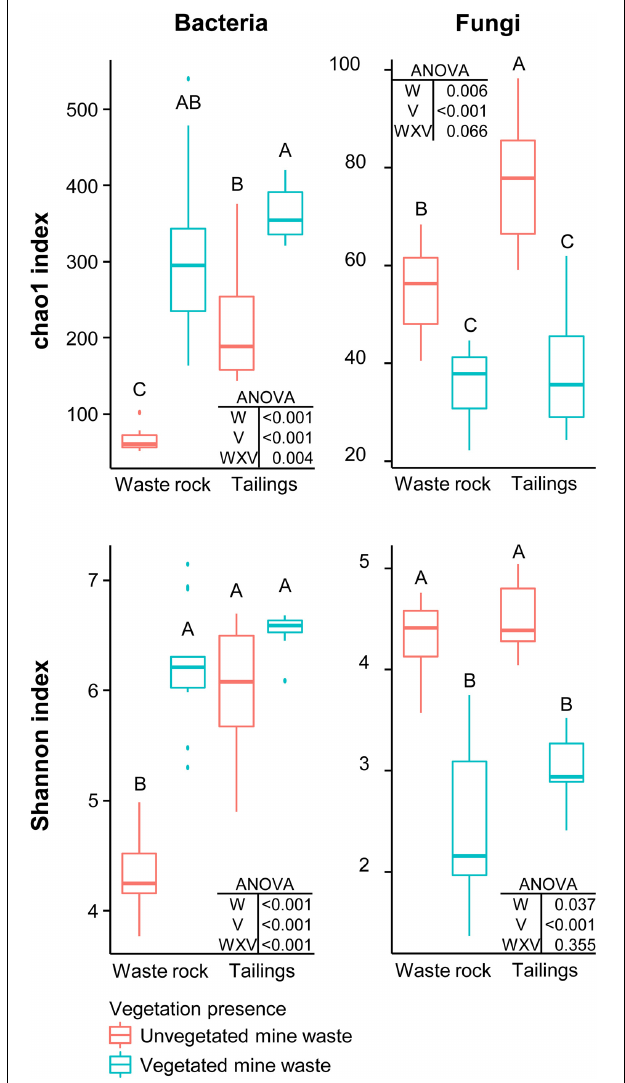
FIGURE 1 | Alpha diversity indices of bacterial and fungal community profiles in field samples. A two-way ANOVA was used to discern how waste type, vegetation presence and their interaction influenced alpha diversity indices. In the ANOVA table, W is waste type; V is vegetation presence; and WXV is the interaction between waste type and vegetation presence. Treatments are composed of two factors: waste rock and tailings as waste type; and vegetated or unvegetated mine waste as vegetation presence. Shared letters between treatments means there is no significant difference between these treatments, as determined by Tukey HSD post hoc pairwise comparison test ( n ≥ 8). Significance level is p <